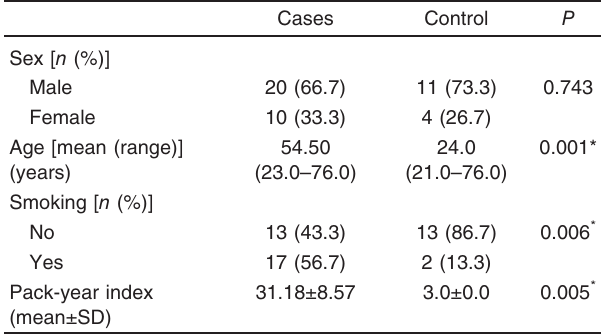
Table 1 Comparison between the two groups studied according to demographic data Cases Control